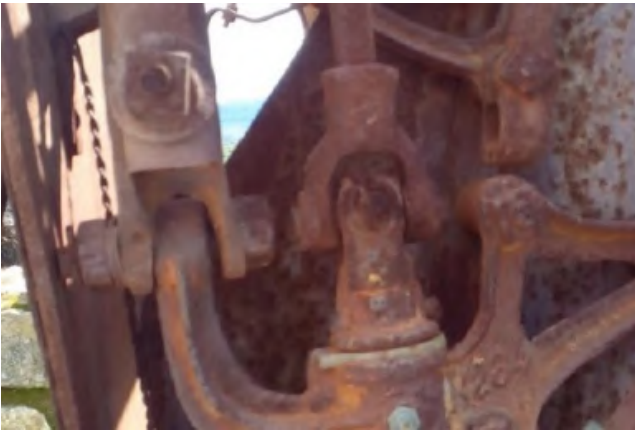
Figure 28. Gimbal joint of transmission of the rotating pushers.